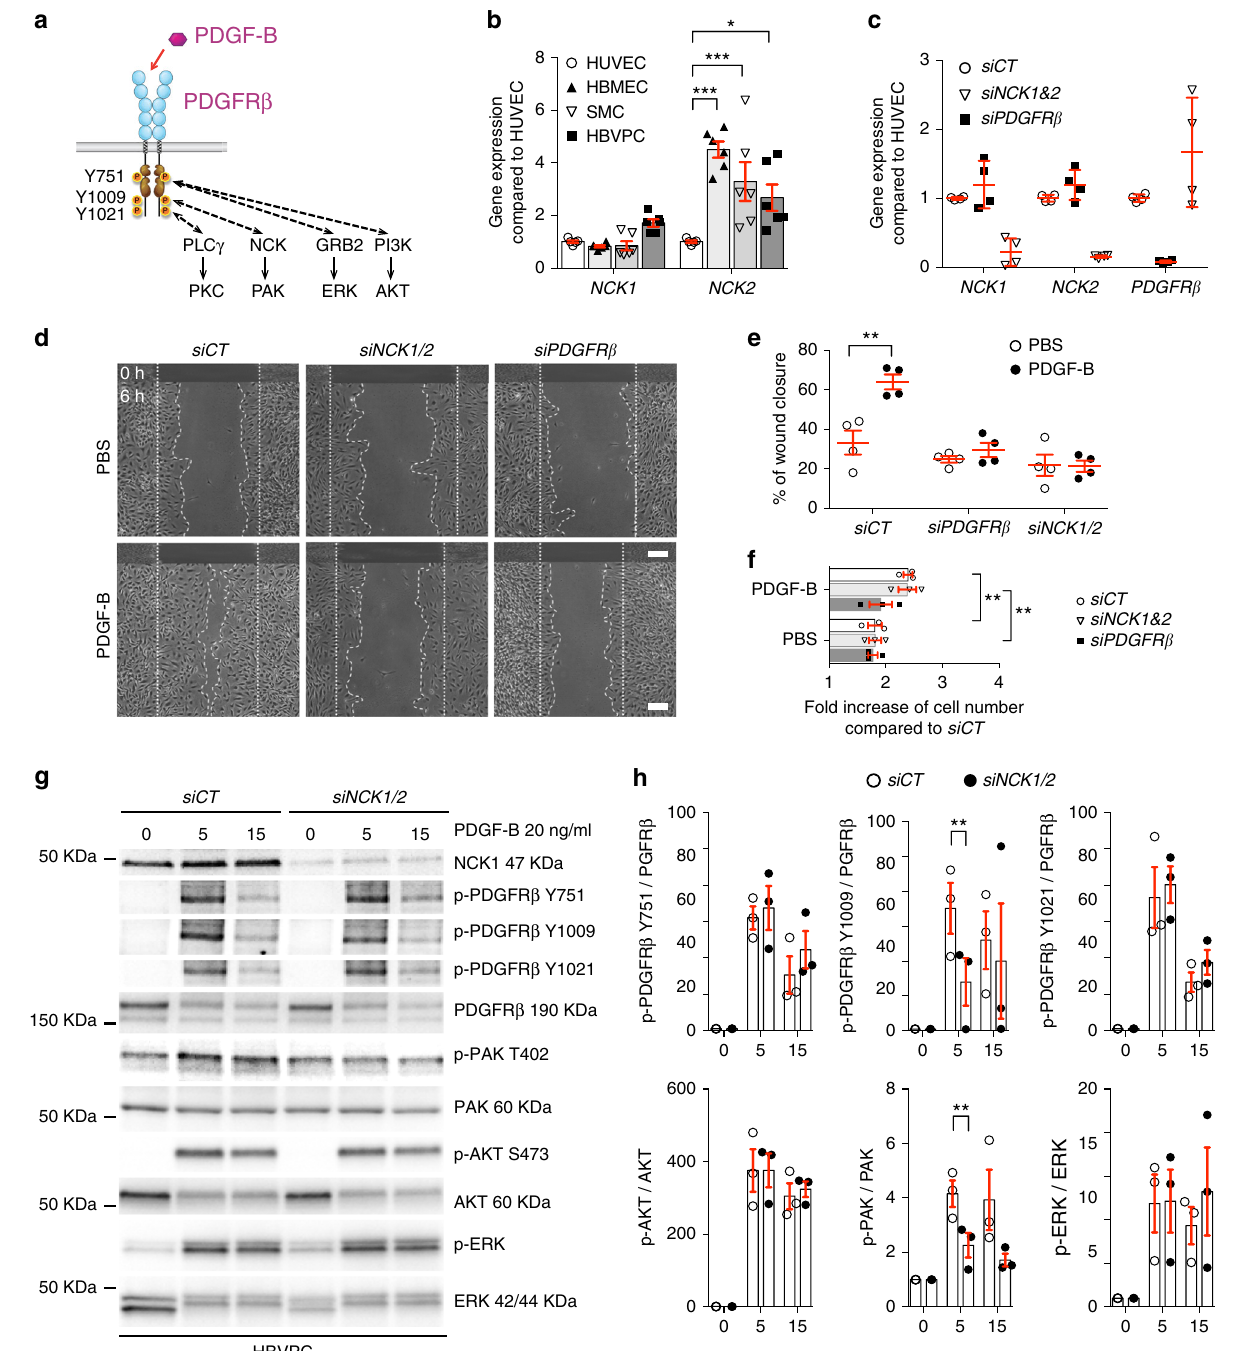
Fig. 6 NCK is essential for PDGF-B-induced pericyte migration in vitro. a Schematic of PDGFR β downstream signaling. NCK adaptor proteins bind the phospho-Y1009 on the PDGFR β receptor to regulate PDGF-B-induced PAK activation, while other downstream effectors bind to different phosphosites. b qPCR measurement of NCK1 and NCK2 levels in HBMEC ( n = 6), human brain SMC ( n = 6), and HBVPC ( n = 6) compared to HUVEC ( n = 5). Error bars represent s.e.m. ⋆ P < 0.05, ⋆⋆⋆ P < 0.001, two-way ANOVA with Sidak ’ s multiple comparisons test. c qPCR analysis of NCK1 , NCK2 , and PDGFR β expression in HBVPC transfected with siRNAs against NCK1 and NCK2 or PDGFR β compared to control siRNA (siCT) ( n = 4 experiments). Error bars represent s.e.m. d Scratch-wound migration assay using HBVPC treated with siRNAs and stimulated with recombinant proteins as indicated for 6 h. Top panels show the wound edges at 0 h. Dashed lines mark wound migration edges at 0 h (straight lines) and 6 h. e Quanti fi cation of wound closure ( n = 4 experiments). Error bars represent s.e.m. ⋆⋆ P < 0.01, Student ’ s t test. f Proliferation assay using HBVPC transfected with control (siCT), NCK1 and NCK2 or PDGFR β siRNAs and stimulated with PDGF-B ( n = 3 experiments). Error bars represent s.e.m. ⋆⋆ P < 0.01, Student ’ s t test. g Western blot using HBVPC stimulated with PDGF-B and probed with the indicated antibodies. h Quanti fi cations of blots shown in g ( n = 3 experiments). Error bars represent s.e.m. ⋆⋆ P < 0.01, Student ’ s t test. Scale bars, 150 μ m ( d